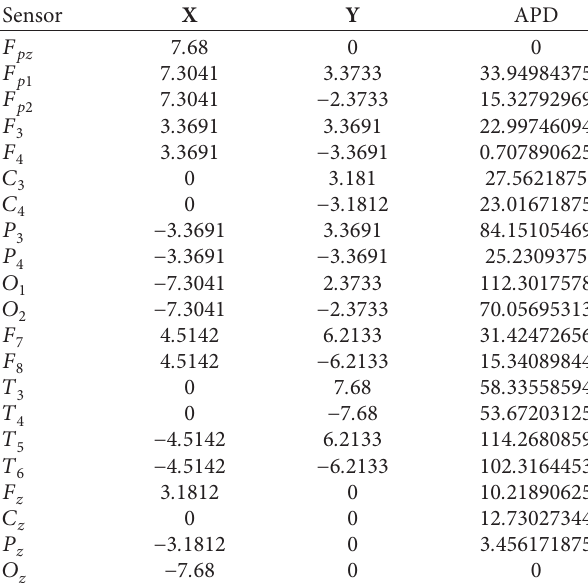
Table 3: Average potential difference (APD) of patient A at the sensor on an MC at time t � 2 [30].